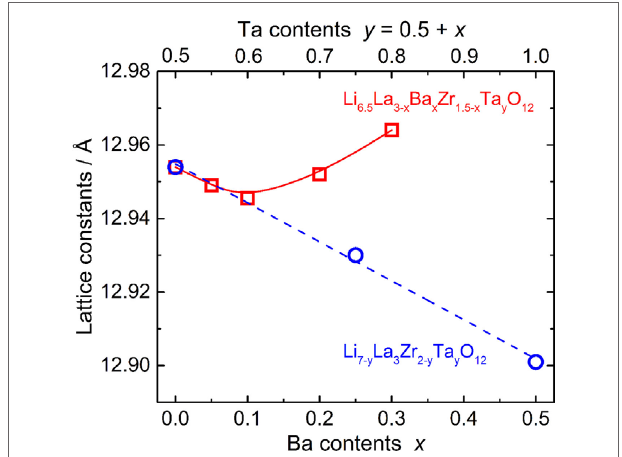
FigUre 3 | lattice constants of cubic garnet-type llBZT plotted against Ba contents x and Ta contents y = 0.5 + x . Lattice constants of